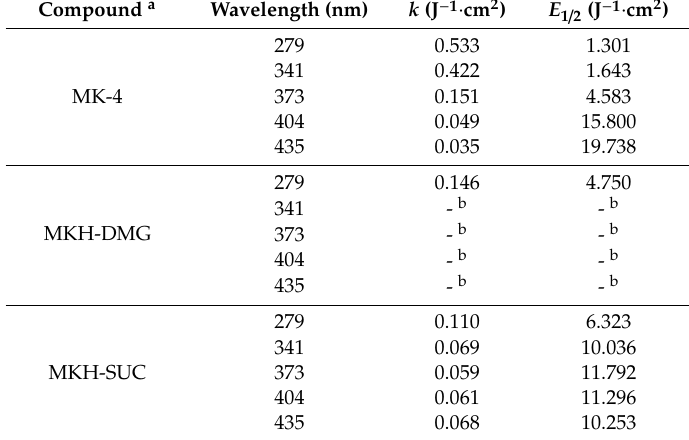
Figure 3. Effects of irradiation wavelength on the photodegradation of MK-4 and MKH derivatives at 25 °C. ( A ) MK-4; ( B ) MKH-DMG; and ( C ) MKH-SUC were irradiated with monochromatic light of wavelengths ○ : 279, ■ : 341, △ : 373, ● : 404, and ▽ : 435 nm. Remaining concentration was calculated as a percentage of the initial concentration of each respective compound. Table 2. The rate constants ( k ) and half-lives ( E 1 / 2 ) of degradation of MK-4 and MKH derivatives in ethanol under di ff erent irradiation intensities of monochromatic light at 25 ◦